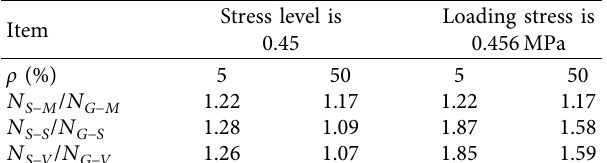
Table 15: Comparison of fatigue life of the SMA-13 mixture